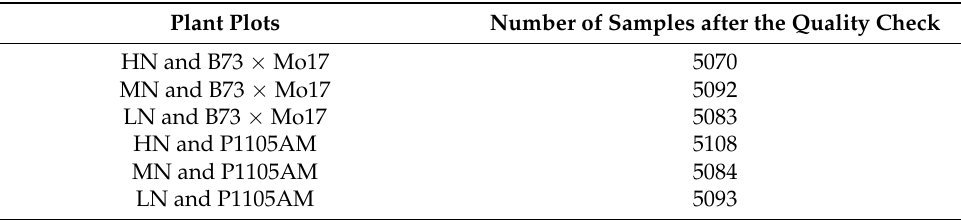
Table 2. Number of samples after the quality check for six plant plots. Plant Plots Number of Samples after the Quality Check HN and B73 × Mo17